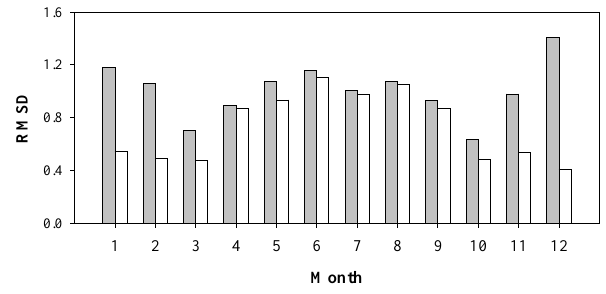
( in situ : blue circles; MODIS: yellow squares) derived (a) a rs (b) Aph and (c) Chl versus field measured data.545